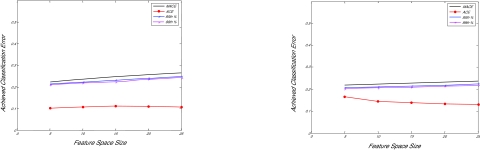
PACE analysis using a SVM-based classifier using the AUC scoring criterion, with a 0.6 MAC threshold. Left Panel: performance without peak selection. Right panel: performance with peak selection.